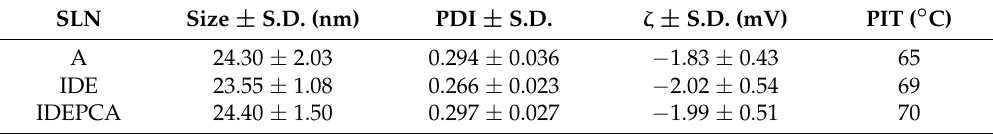
Table 4. Mean size (size), polydispersity index (PDI), zeta potential ( ζ ), and phase